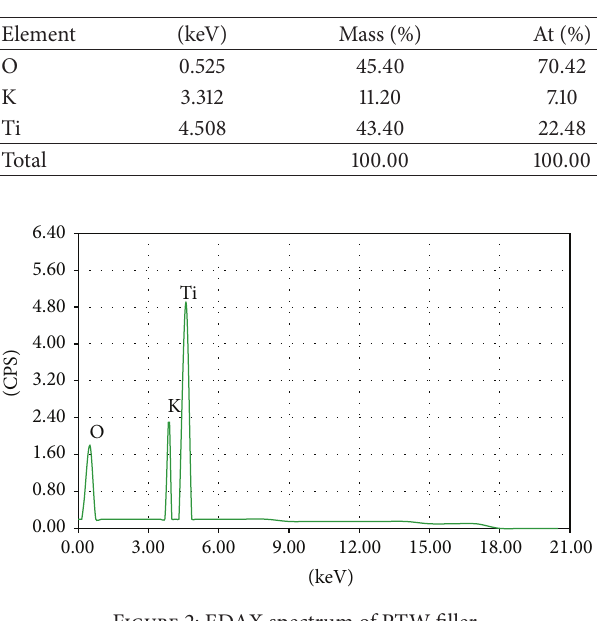
Table 2: Elemental mapping of PTW filler.